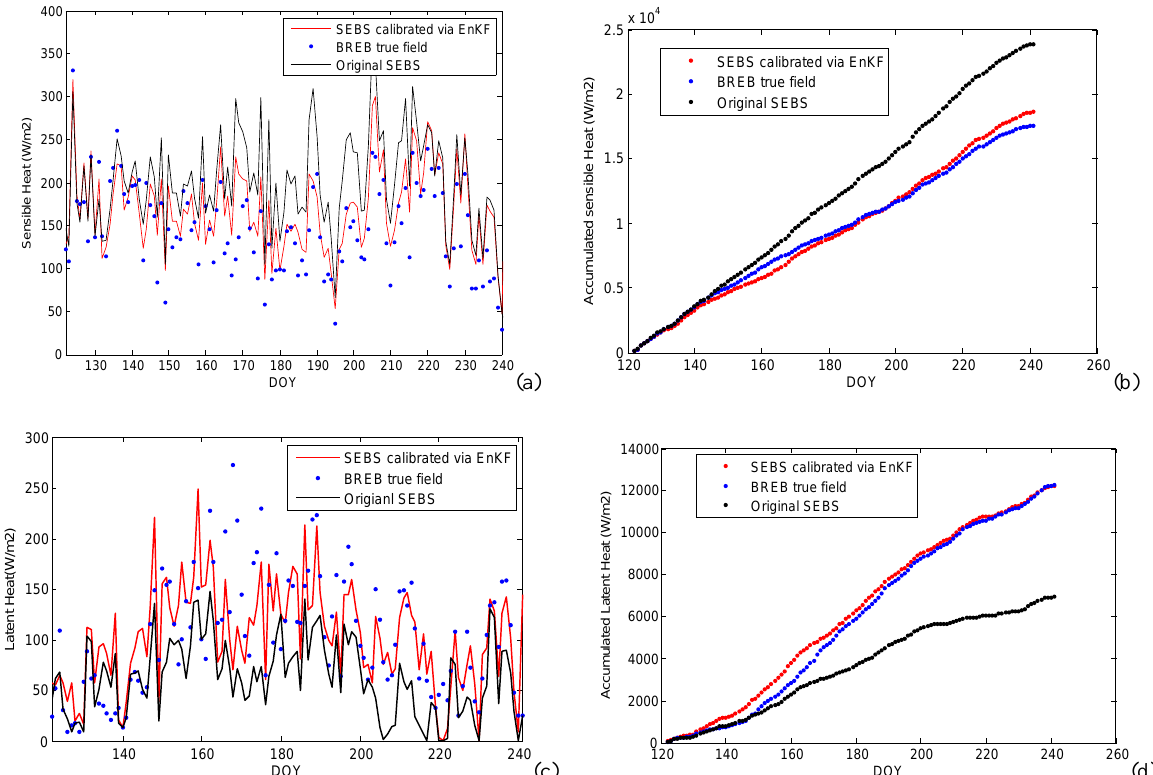
Fig. 6. Comparison in heat flux estimates: (a) sensible heat, (b) accumulated sensible heat, (c) latent heat, and (d) accumulated latent heat.